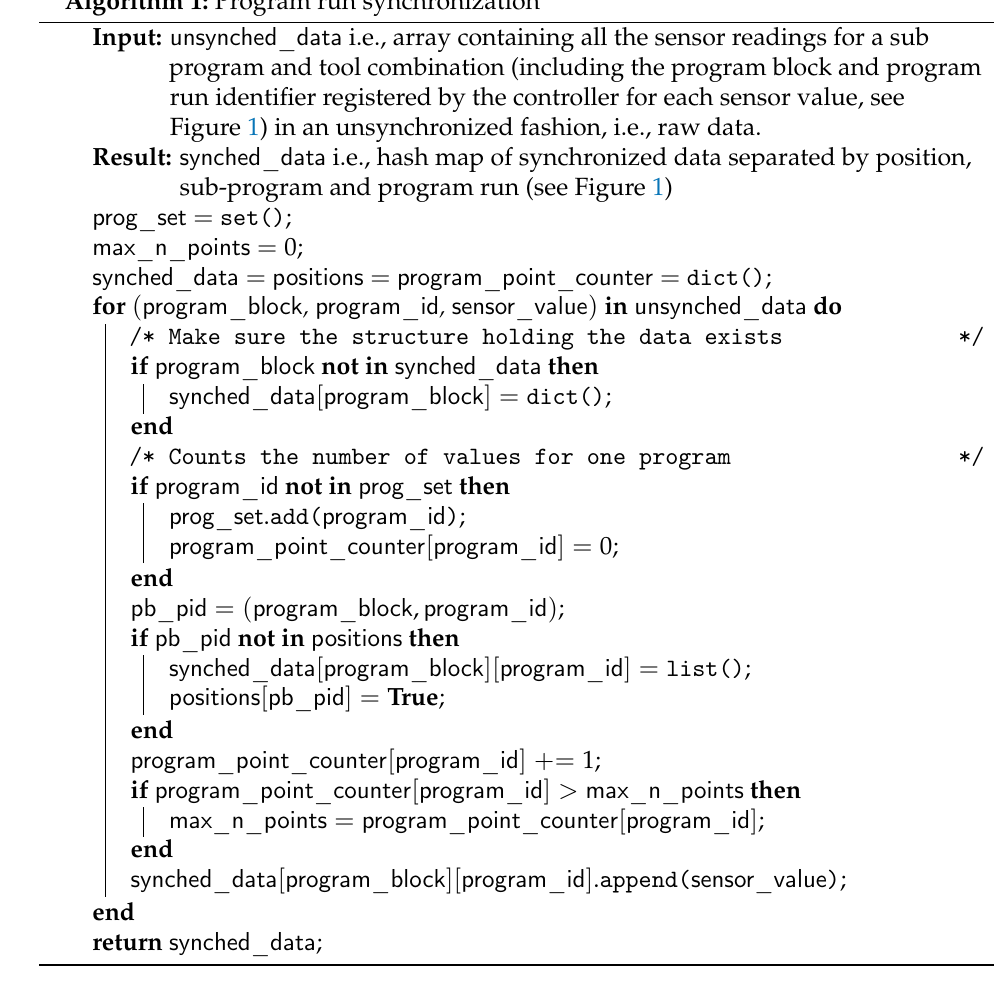
Algorithm 1: Program run synchronization